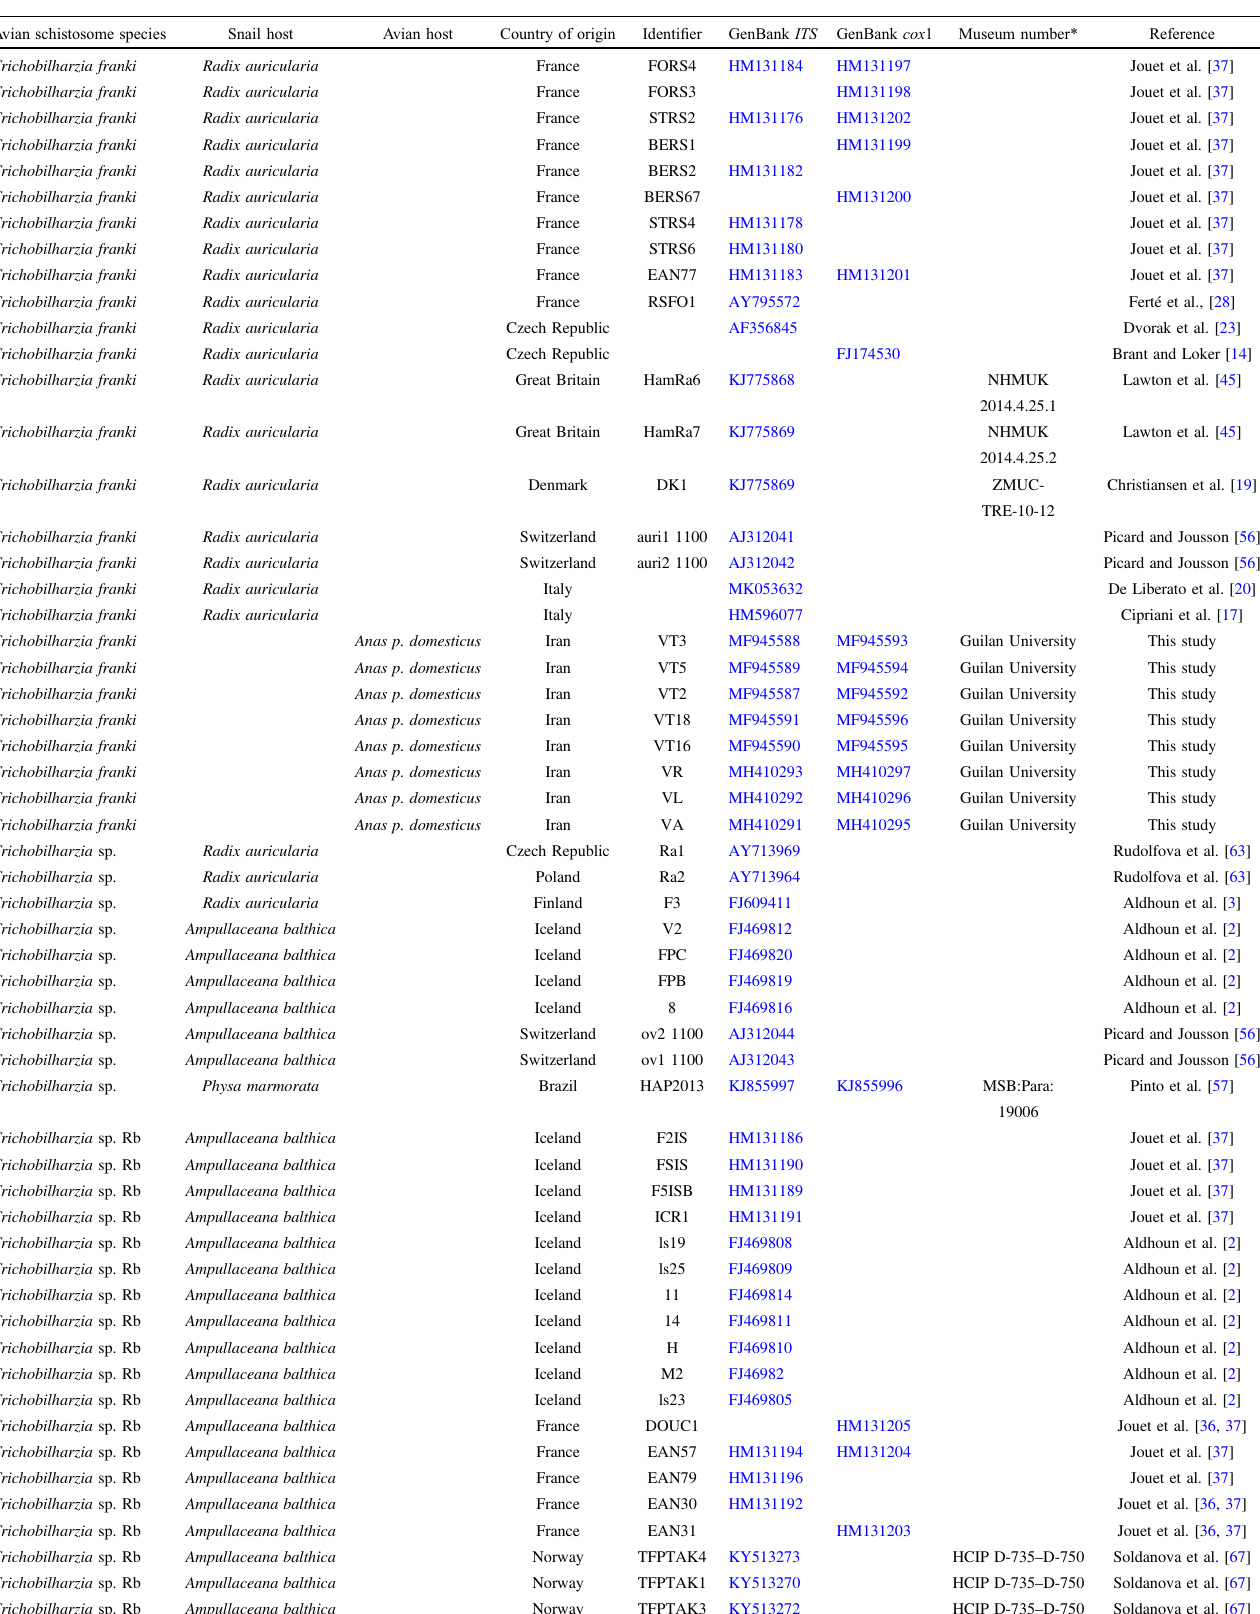
Table 4. Specimens used in this